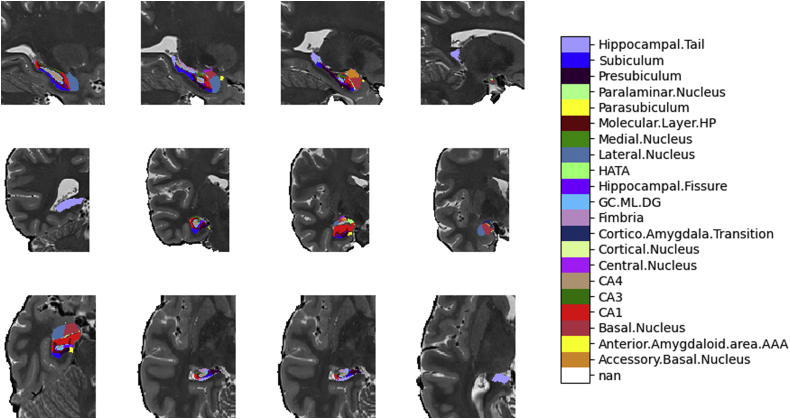
Sagittal (upper row), coronal (middle row), and axial (lower row) images of the hippocampus and the amygdala subregions performed using FreeSurfer version 6.0 subcortical reconstruction. AAA, anterior amygdaloid area; GC.ML.DG, granule and molecular cell layer of dentate gyrus; HATA, hippocampal amygdala transition area.